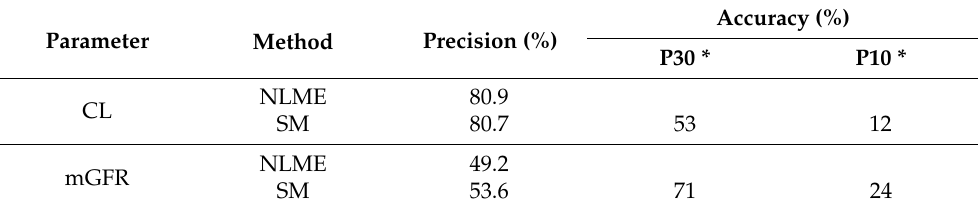
Figure 4. ( A ) Comparison of the measured iohexol plasma clearance based on a nonlinear mixed effects model (CL NLME ) and calculated iohexol plasma clearance based on the simplified method (CL SM ) in goats (triangles) and pigs (circles). Solid line, line of unity. ( B ) Bland–Altman plot of agreement between iohexol plasma clearance determined by a nonlinear mixed effects model and by the simplified method for goats (triangles) and pigs (circles). Dotted lines represent bias, upper and lower limits of agreement. Grey shaded areas represent the 95% confidence intervals of the bias, upper and lower limits of agreement. Table 1. Precision and accuracy of iohexol plasma clearance and mGFR calculated by a nonlinear mixed effects model and the simplified method.